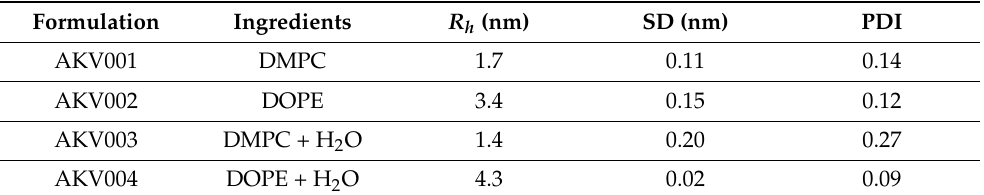
Table 3. Apparent average hydrodynamic radii ( R h ) with standard deviation and polydispersity index (PDI) obtained from the DLS